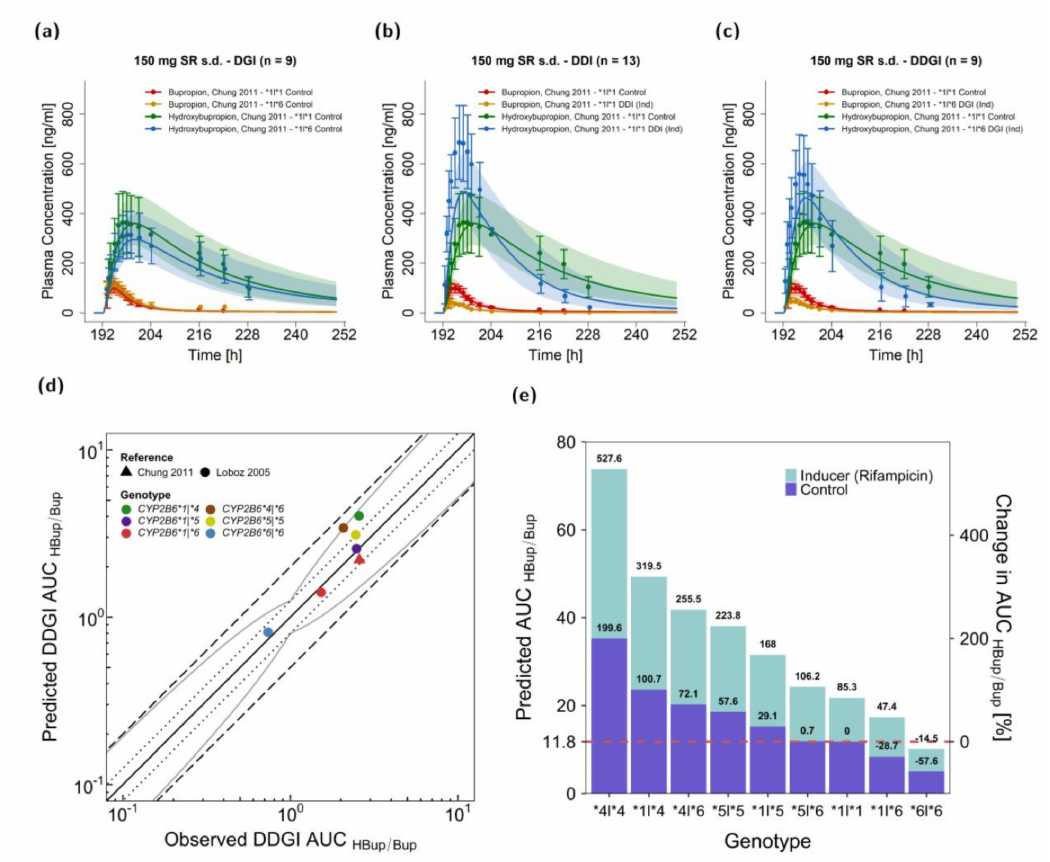
Figure 6. Rifampicin–bupropion CYP2B6 DDGI. Predicted compared to observed plasma concentration-time profiles are illustrated for the CYP2B6 bupropion DGI ( CYP2B6*1|*6 compared to CYP2B6*1|*1 ) ( a ), for rifampicin–bupropion DDI in individuals with the CYP2B6*1|*1 genotype ( b ) and for the rifampicin–bupropion DDGI for individuals with the CYP2B6*1|*6 genotype compared to carriers of the CYP2B6*1|*1 genotype ( c ). The predicted and observed plasma concentrations under the combined effects of CYP2B6 genetic polymorphism and perpetrators are shown in orange and blue, respectively, while the control is shown in red and green. The solid line illustrates the geometric mean of the population predictions ( n = 500) and the shaded area the geometric standard deviation. Predicted compared to observed effect ratio plot for the hydroxybupropion–bupropion ratio of AUC values are shown for six different genotypes after rifampicin induction ( d ). Different colors indicate the genotypes and different shapes the respective studies ([35,44]). The straight solid line marks the line of identity, the curved solid lines show the prediction acceptance limits proposed by Guest et al. including a 1.25-fold variability [85]. Dotted lines indicate 1.25-fold and dashed lines indicate 2-fold deviation. Predicted effects of rifampicin-bupropion DDGIs on the hydroxybupropion-bupropion AUC ratios were compared to CYP2B6*1|*1 without co-administration of rifampicin ( e ). Details on study protocols and DDGI ratios are provided in the Supplementary Materials. AUC area under the plasma concentration-time curve, DGI: drug–gene interaction, DDI: drug–drug